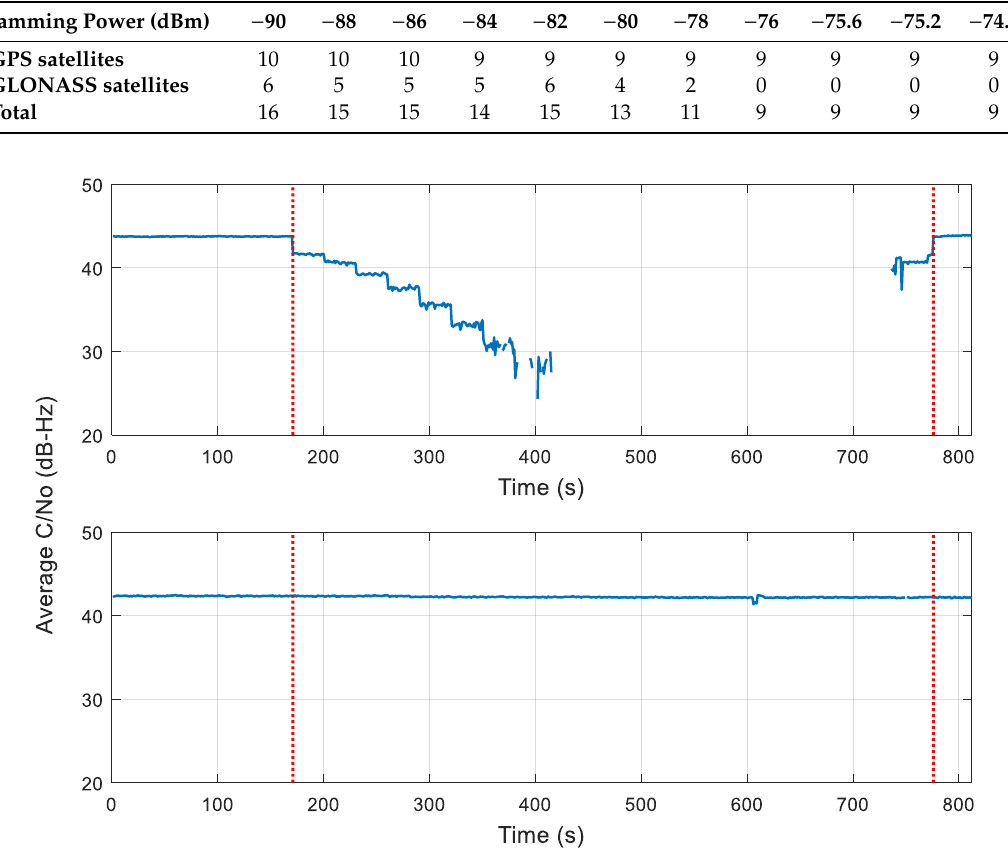
Figure 13. Averagecarrier-to-noiseratioofscenario#5. ( Topfigure )—GPSmeasurements; ( bottomfigure )— Figure 13. Average carrier-to-noise ratio of scenario #5. ( Top figure )—GPS measurements; ( bottom GLONASS figure )—GLONASS measurements.